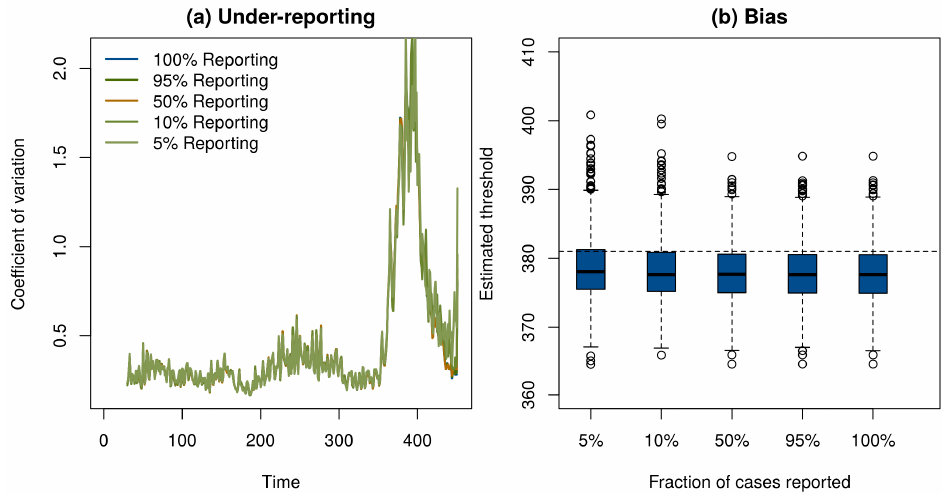
Figure 3. ( a ) Under-reporting had negligible effect on the ability of the moving window coefficient of variation to respond to the approach to the vaccination threshold. ( b ) A hyperbolic approximation was used to forecast the time the vaccination threshold would be reached. The estimated crossing time in 1000 simulations (boxplots) was on average slightly earlier than the true time of year 381 (horizontal dashed line). Under-reporting had little effect on the precision or bias of predictions.